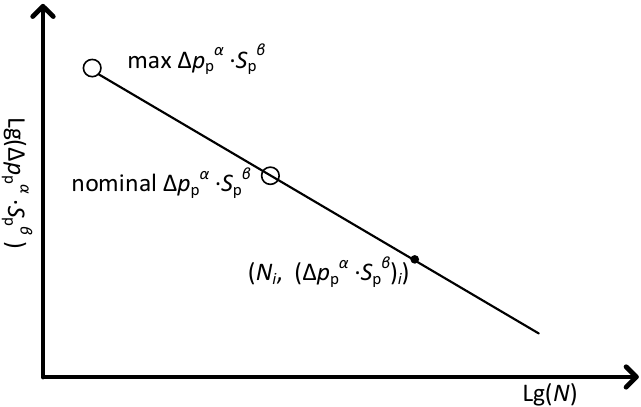
Figure 5. The N i identification using the linear log-log S-N curve of the pump.